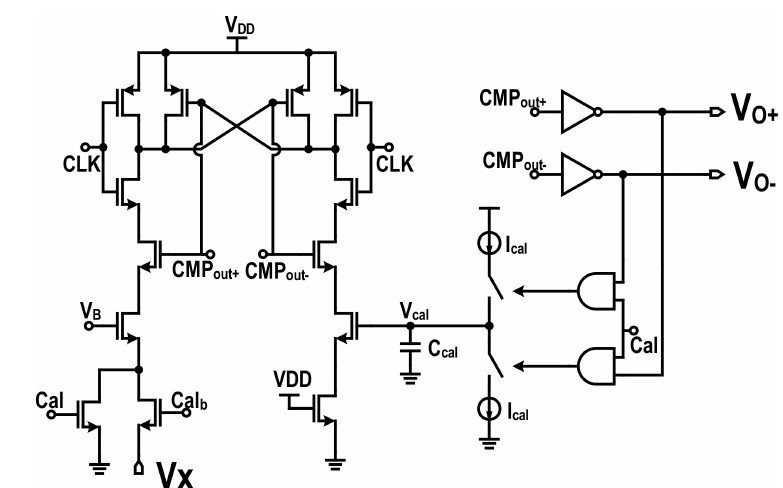
Figure 9. Low o ff set latched comparator.